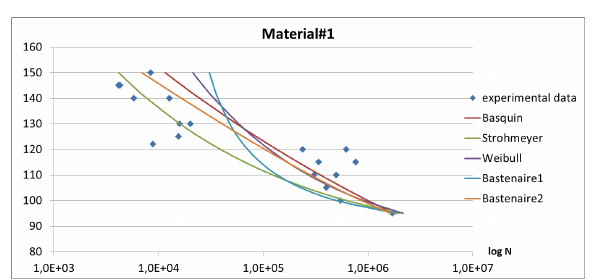
Figure 2. Applied fatigue models for Material#1.